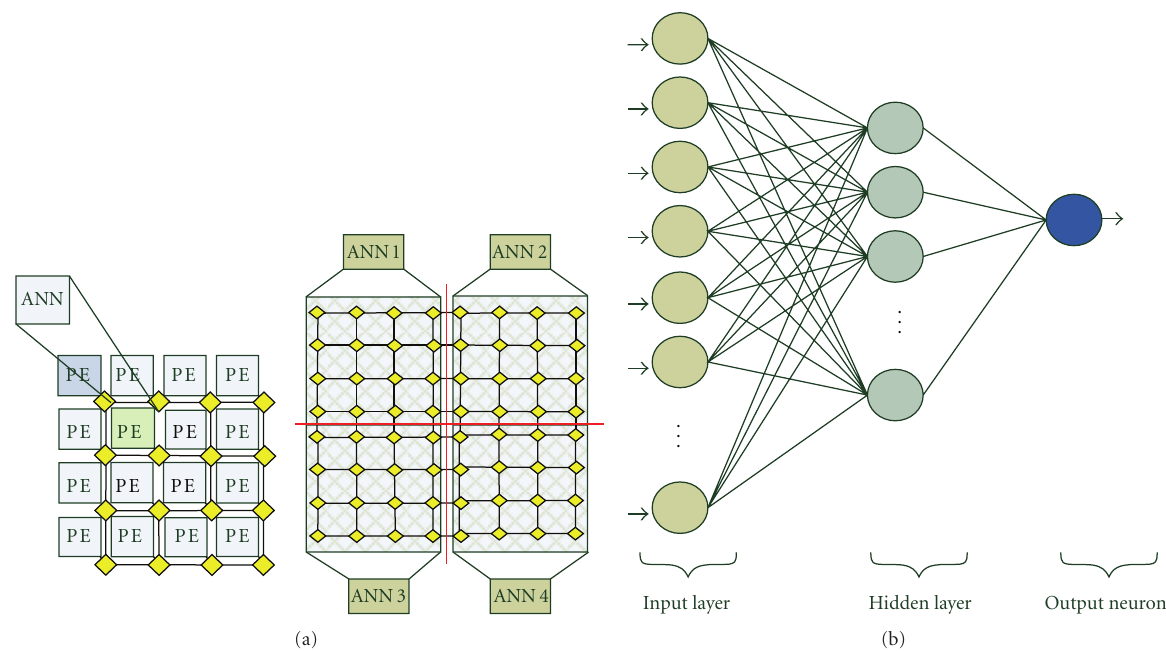
Figure 2: (a) ANN predictor with NoCs and an 8 × 8 network partition into four 4 × 4 networks with their ANNs; (b) Structure of the neural network.